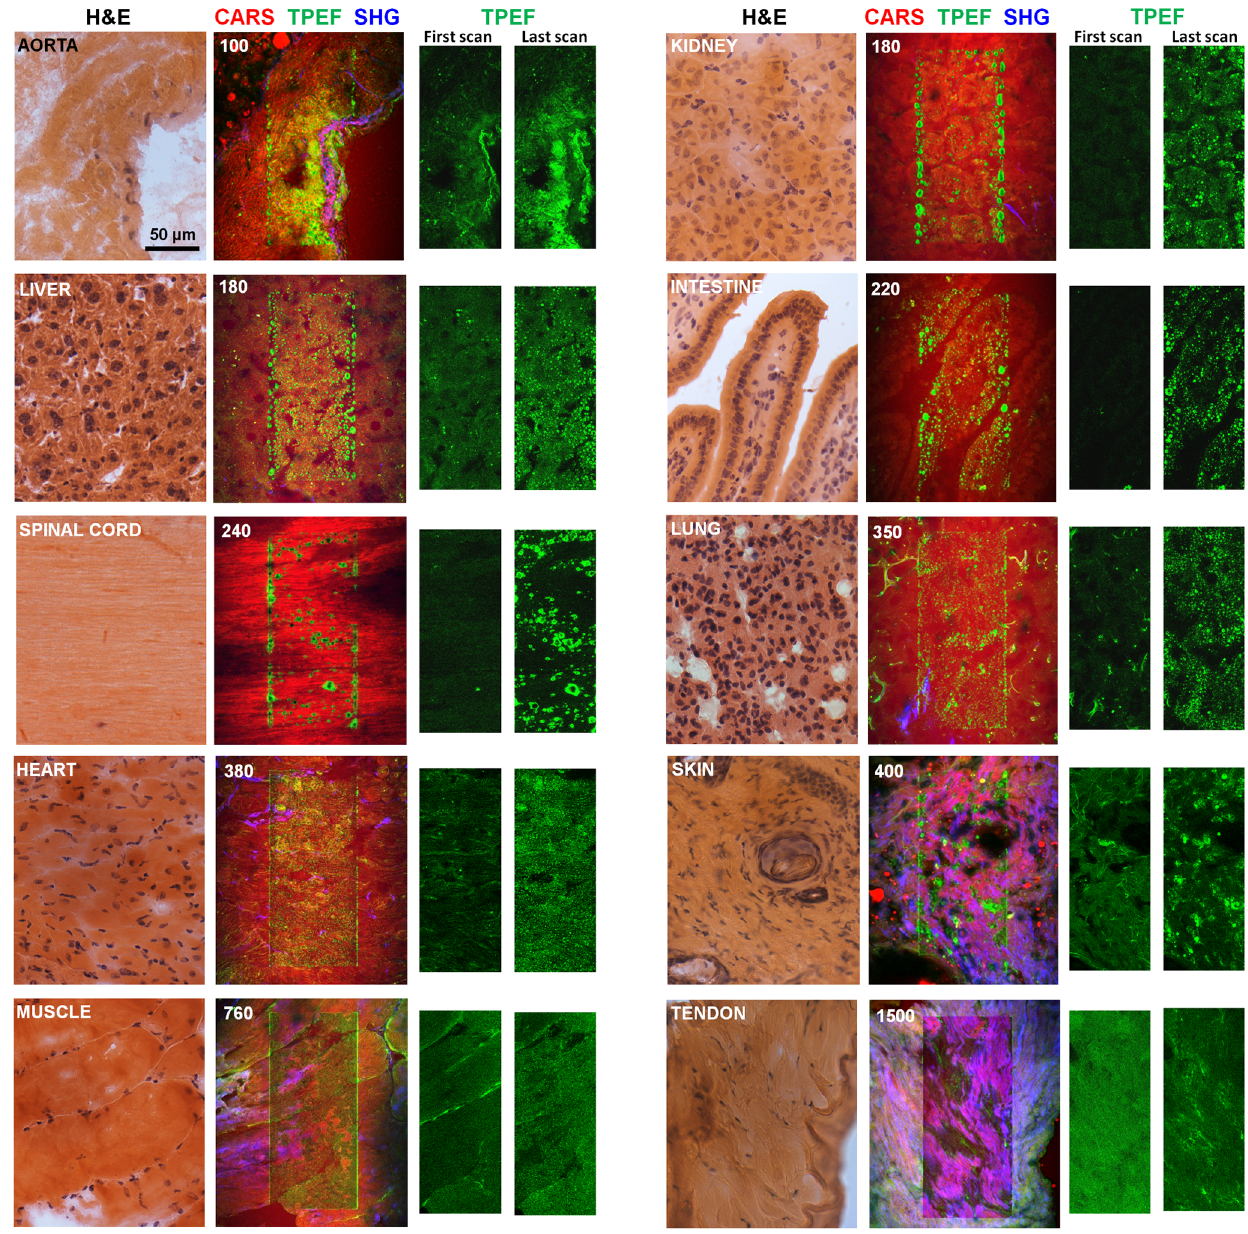
Figure 5. Photodamage on rehydrated cryosections of different mouse tissue types. The repetitive irradiation was performed in the central part of the images. CARS (red), TPEF (green) and SHG (blue) signals were acquired. The total number of scans used to produce the damage is also reported. The TPEF images of the first and last scan are shown for comparison. All irradiations were performed using the same experimental settings and therefore the scan numbers can be compared. Histological H&E staining of consecutive sections is reported as reference to visualize the tissue structures. All experiments were performed with a total laser power of , 52 mW in the sample.